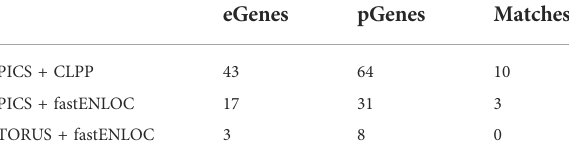
TABLE 1 Identi fi ed eGenes differ from classic gene mapping